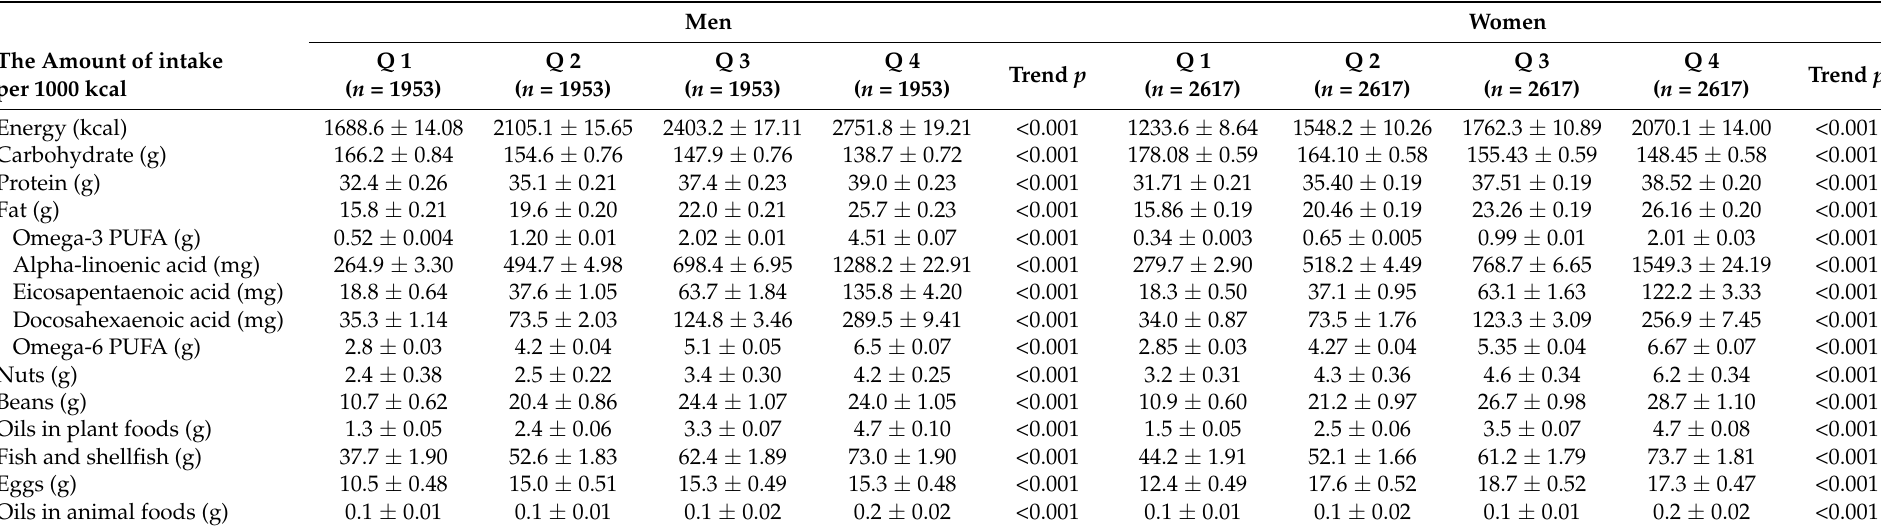
Table 2. Daily nutritional intake of the participants according to dietary omega-3 polyunsaturated fatty acids intake. Men Women